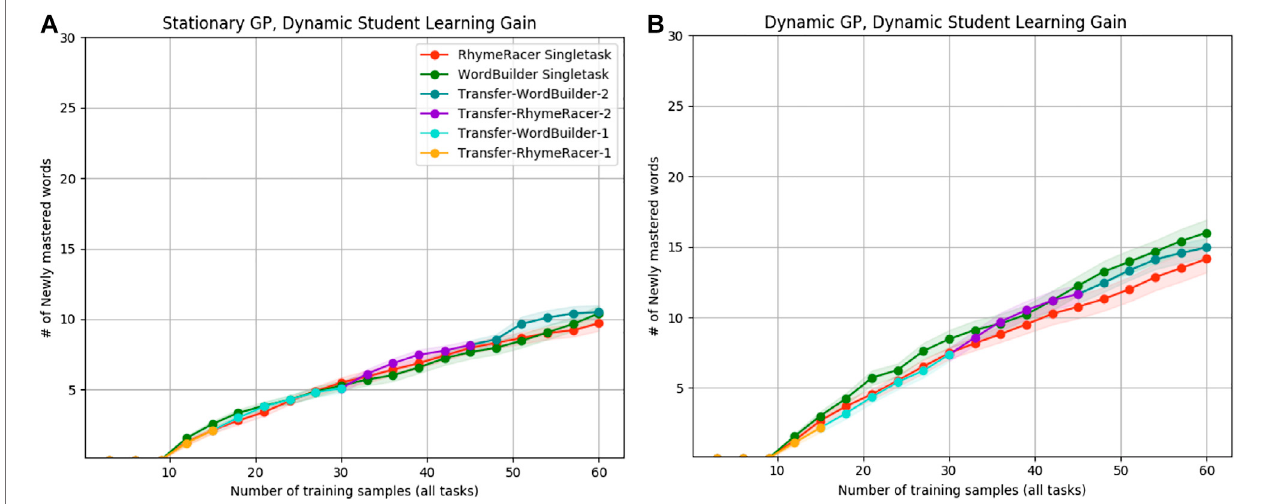
FIGURE 10 | Student learning gains under static-model-dynamic-student (A) and dynamic-model-dynamic-student (B) simulations. Students tutored by a dynamic GP model mastered nearly 50% more